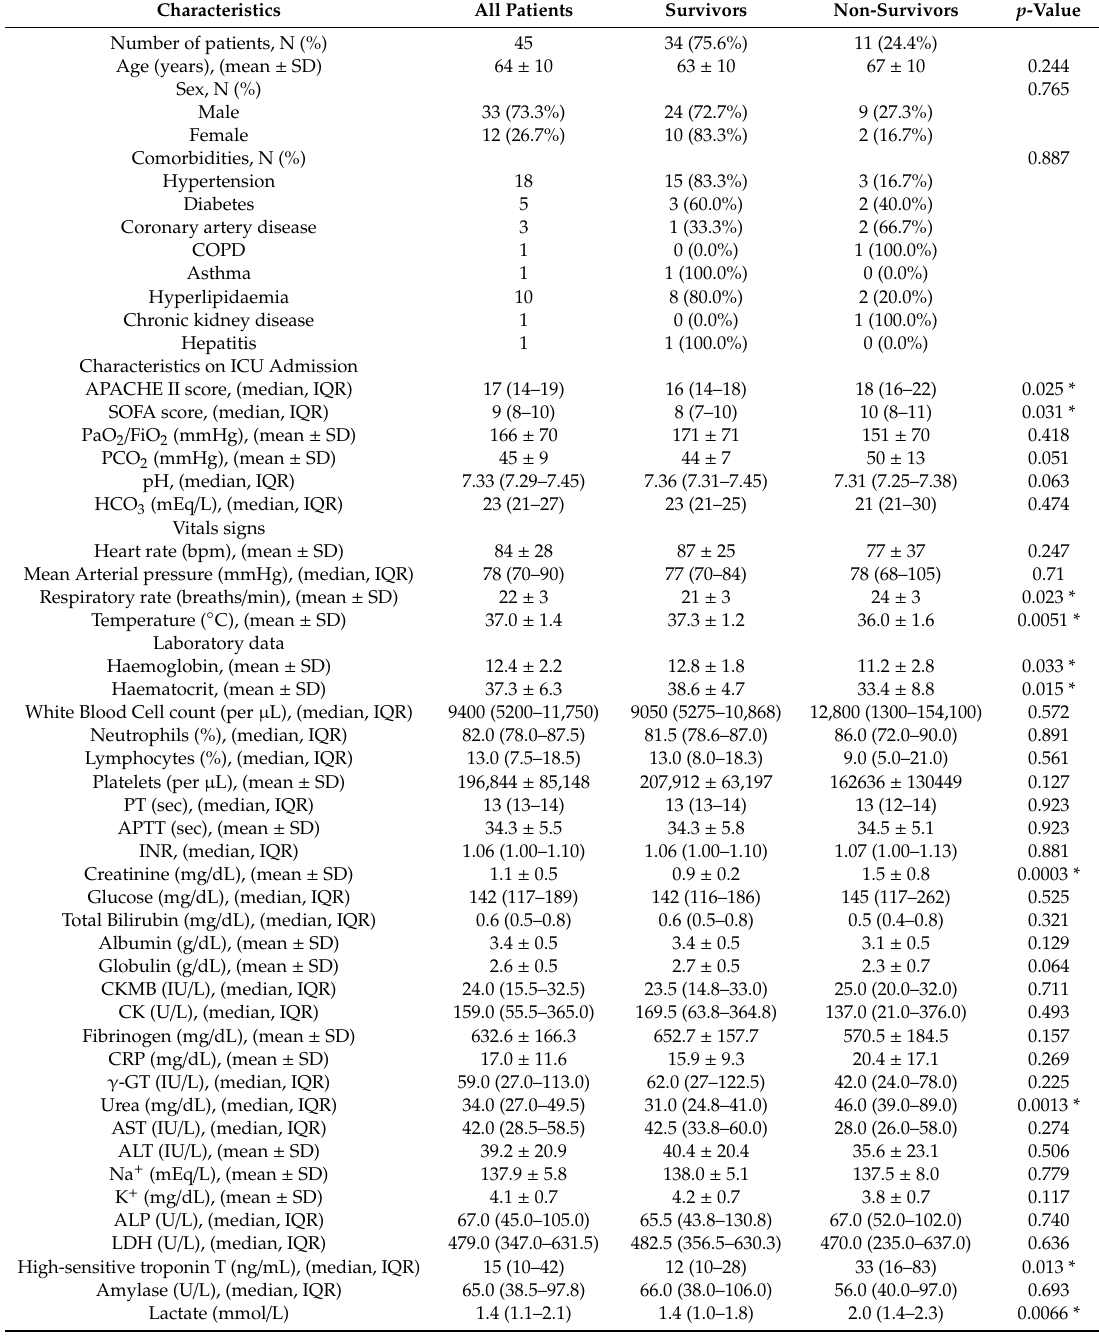
Table 1. Clinical characteristics and laboratory data in critically ill patients on admission to the ICU. Patients’ outcome and demographics are also